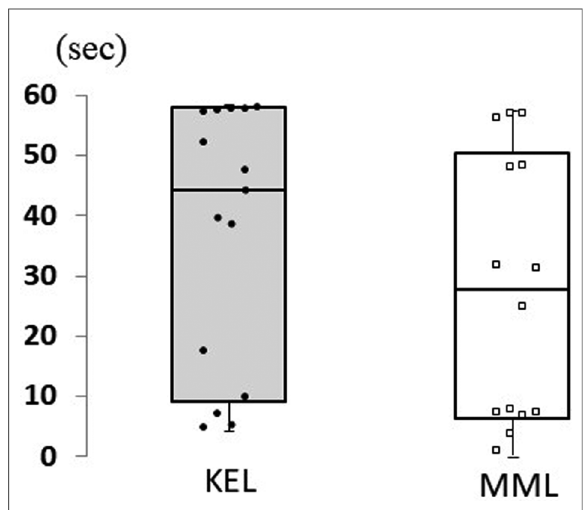
FIGURE 6 Difference in balancing time between KEL and MML methods. To examine the differences in the balancing time because of the differences in learning methods, the difference subtracted pre- balancing time from post-balancing time. No signi fi cant difference was found between the KEL and MML methods in terms of improved balancing time; it improved for both learning